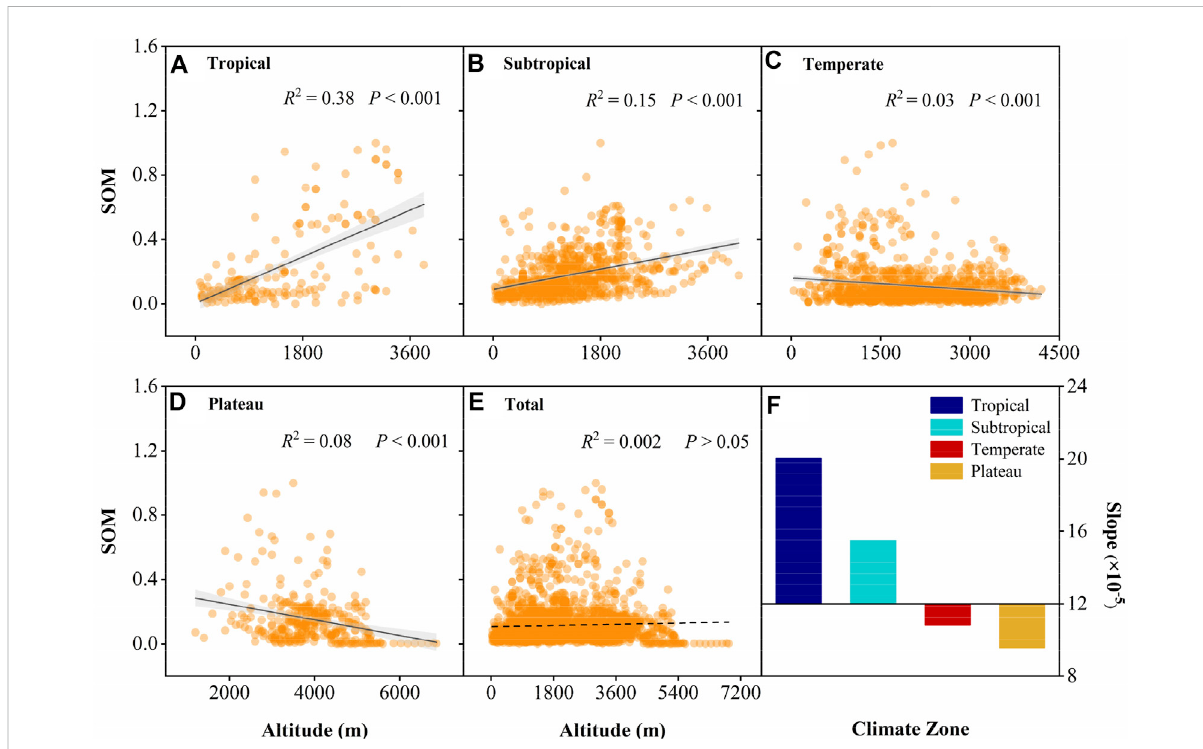
FIGURE 3 Relationship between soil organic matter content and altitude across climatic zones. (A – E) Trends in SOM content with altitude in different climatic zones, respectively. (F) Slopes of SOM content in comparison to altitude in different climatic zones. Tropical: n = 185, subtropical: n = 778, temperate: n = 1,079, plateau: n = 328, total: 2,370; SOM data in the fi gure were normalized by min-max normalization. Shaded areas indicate the 95% con fi dence